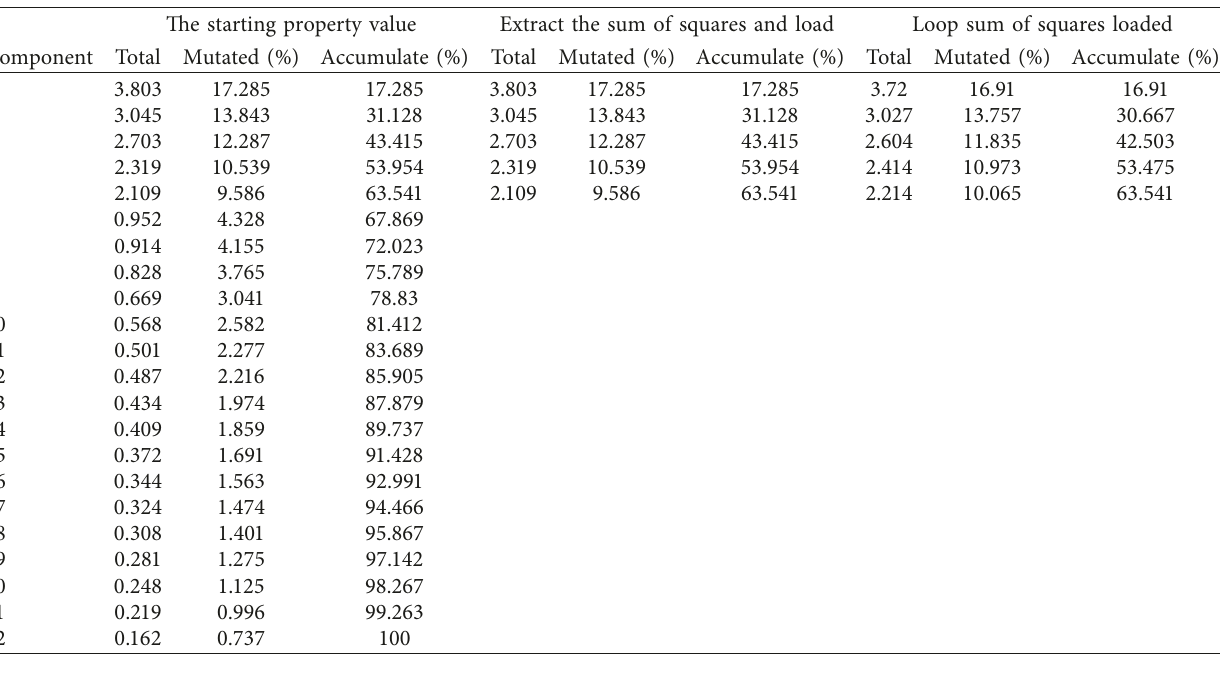
Table 15: Total variance of interpretation.